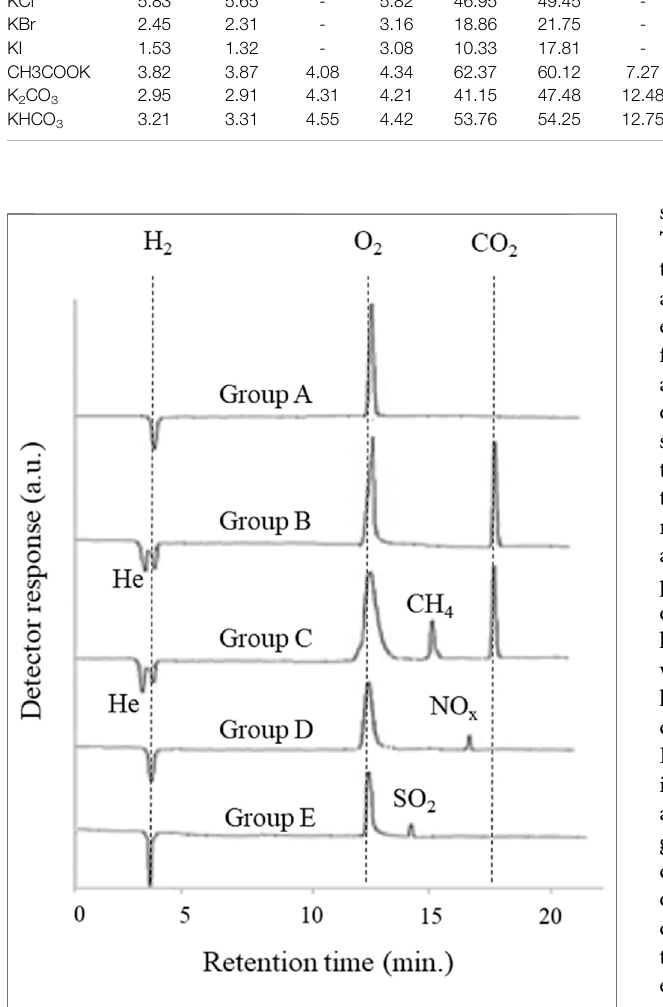
FIGURE 3 | Released gases in fi ve groups of salts in H 2